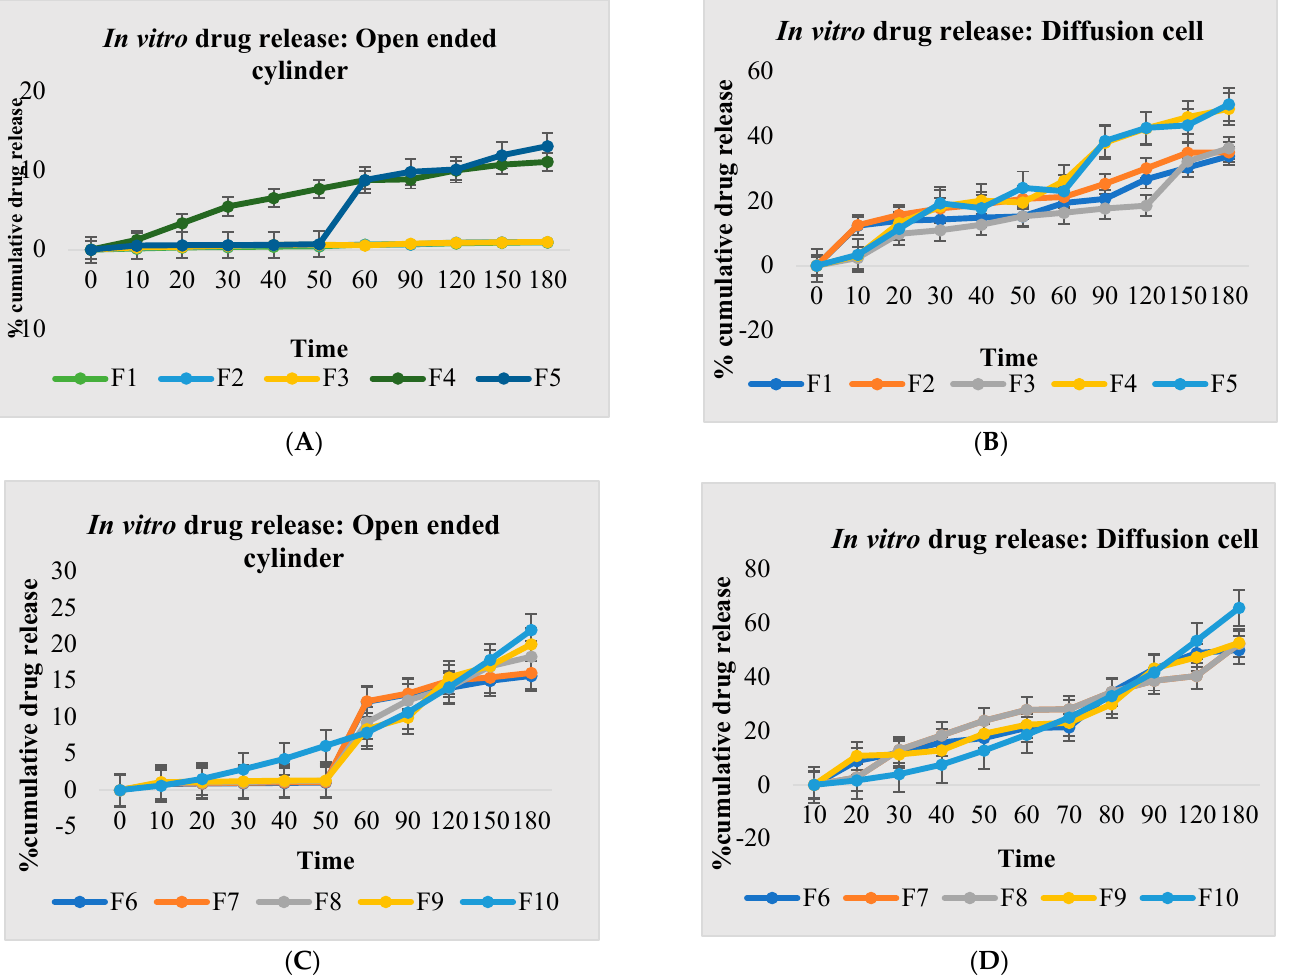
Figure 3. Percent cumulative drug release from gel formulations. ( A ) Open − ended cylinder (F1 to F5), ( B ) diffusion cell apparatus (F1 to F5), ( C ) Open − ended cylinder (F6 to F10), ( D ) diffusion cell apparatus (F6 to F10). Table 3. Release kinetics for optimized formulation